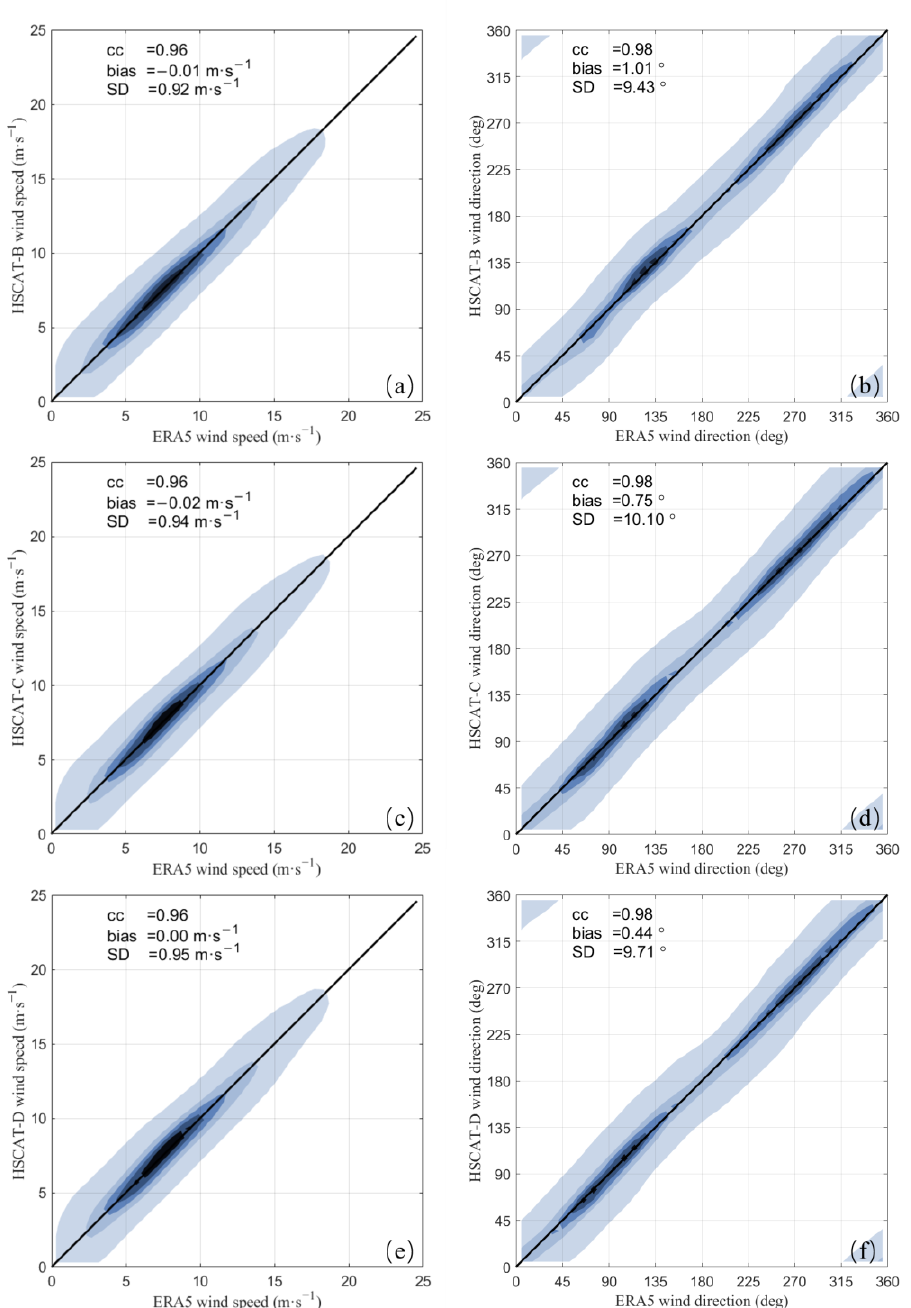
Figure 3. Contour plots of HSCATs versus ERA5 winds. Left panels ( a , c , e ) and right panels ( b , d , f ) show the comparison of wind speeds and directions separately. The upper, middle, and lower panels correspond to HSCAT-B, -C and -D, respectively.